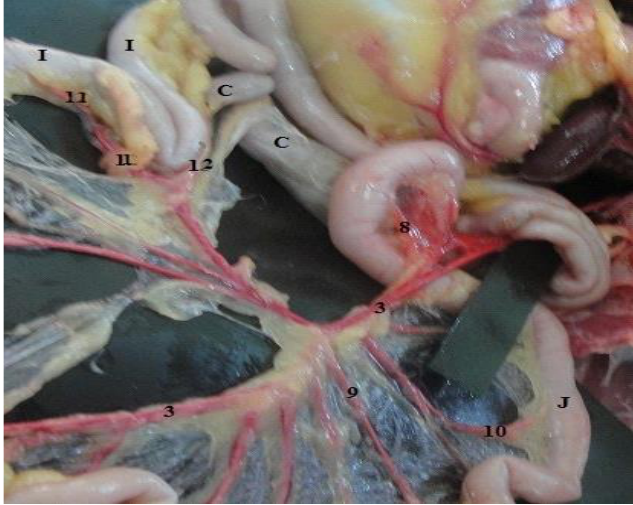
Figure 8 . Photograph illustrates blood supply of the large intestine in male turkey. The caudal mesenteric artery supplies the ileum and rectum.C-B: base